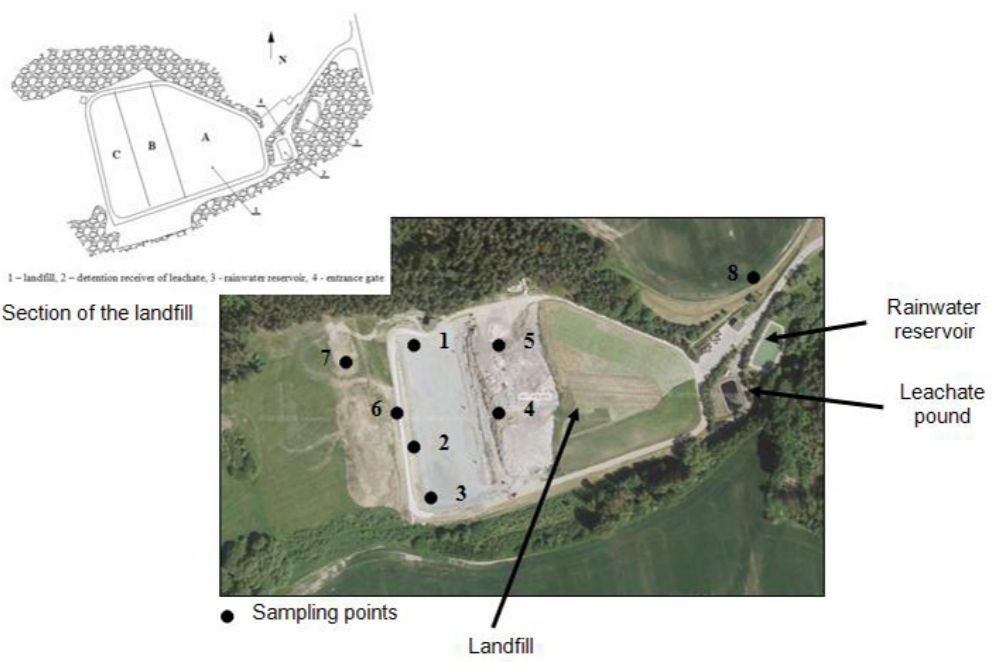
Figure 1. Map of Štˇepánovice landfill and sampling points. Table 1. Content of heavy metals in examined soil